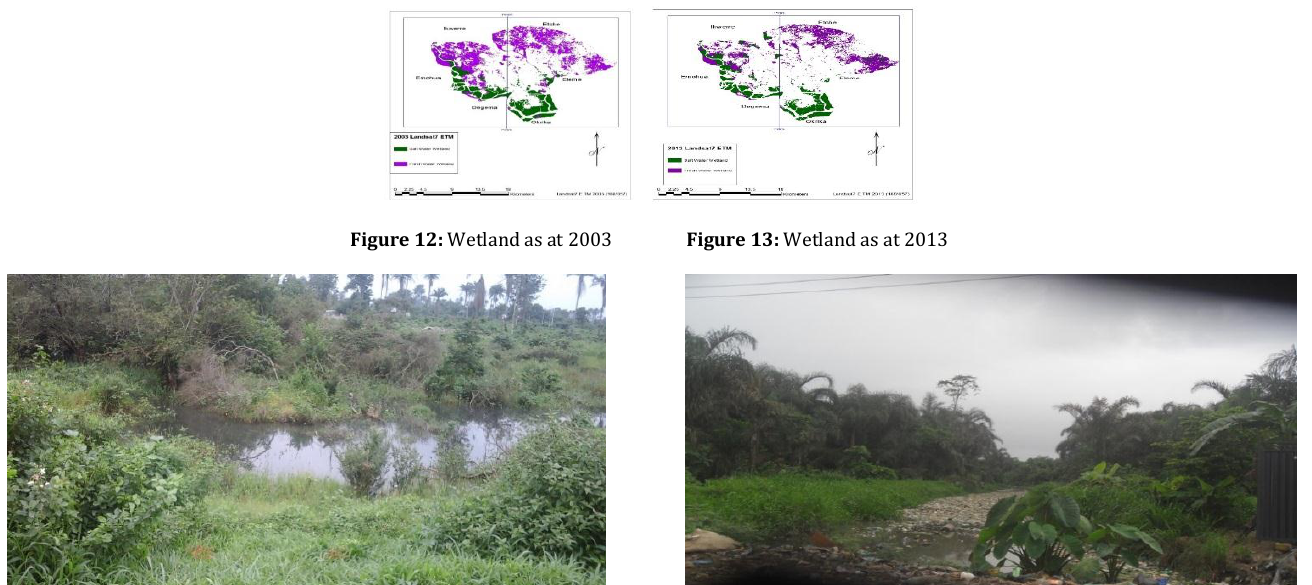
Figure 10: Wetland as at 1984 Figure 11: Wetland as at 1999